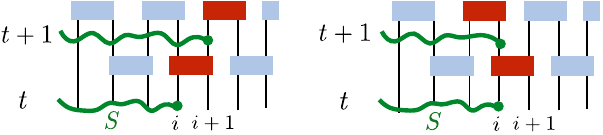
FIG. 2. A Pauli string S (green) with its rightmost nonidentity operator on site i at time t has its right front on the gate ð i; i þ 1 Þ (red). Under the action of the circuit, the front moves forward if the end point of the string moves to ( i þ 1 ) at time t þ 1 (left), while the front moves backward if the action of the circuit leaves the end point at site i